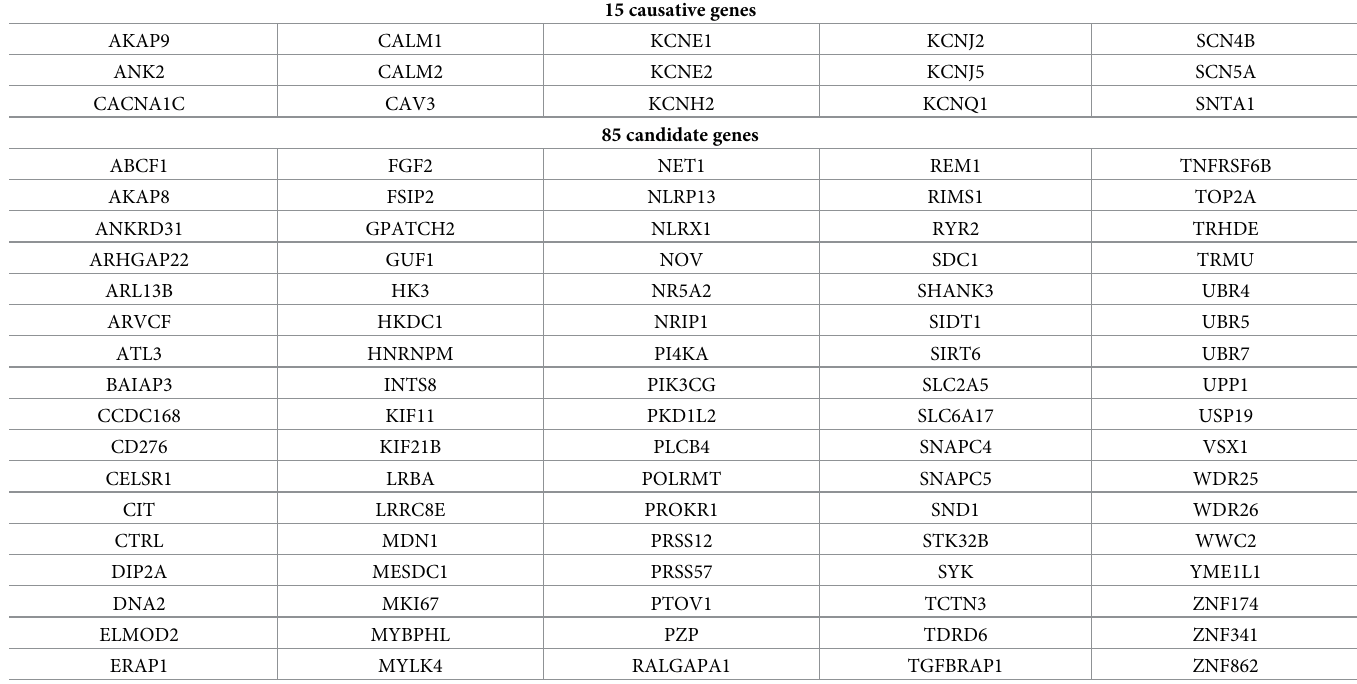
Table 1. List of 100 target genes explored in this